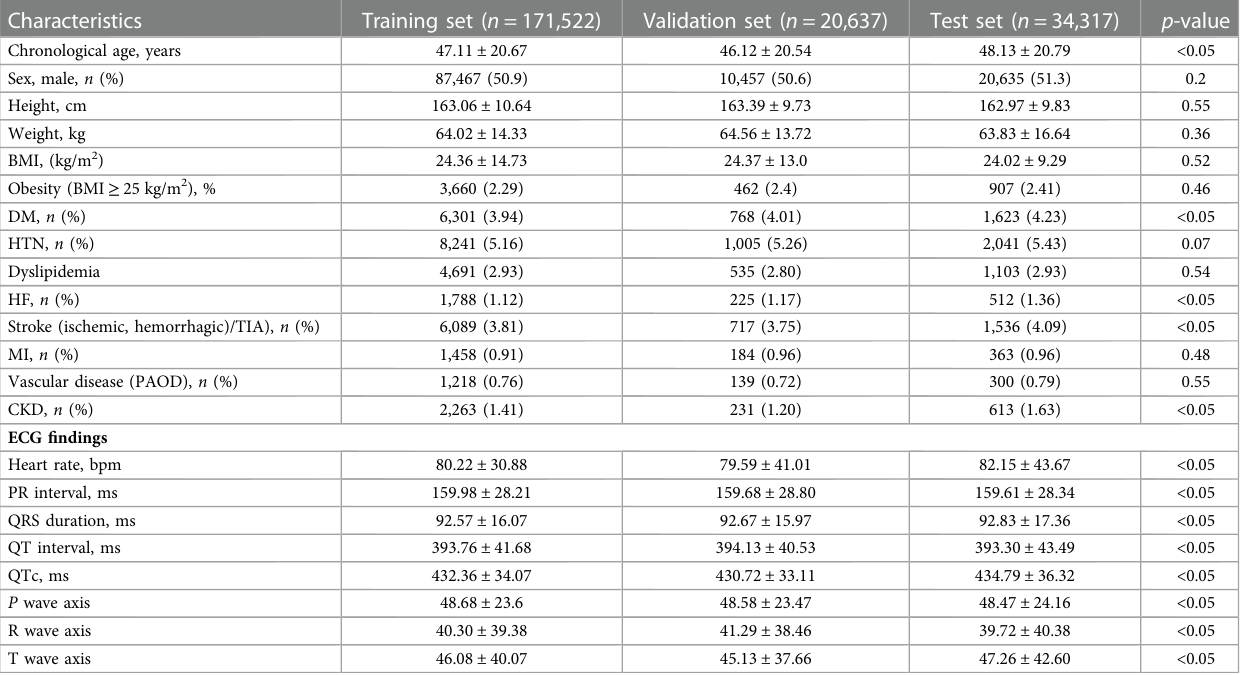
the mortality and cardiovascular outcomes is graphically shown using penalized B-spline curves fi tted to the Cox proportional hazards model in the overall population and sex-strati fi ed population, respectively ( Supplementary Figure S1 ). The spline curves according to the gap between the AI-ECG heart age and CA and the hazard ratio (HR) of the all-cause mortality and cardiovascular outcomes are presented in Supplementary Figure S1 . A non-linear J-shaped association was found in the gap between the AI-ECG heart age and CA variables and the all- cause mortality and CVD. Univariate Cox regression models showed signi fi cant hazard ratios (HRs) for chronological age, gender, DM, HTN, HF, stroke, myocardial infarction (MI), and chronic kidney disease (CKD), as well as AI-ECG heart age in predicting all-cause and cardiovascular-related outcomes.